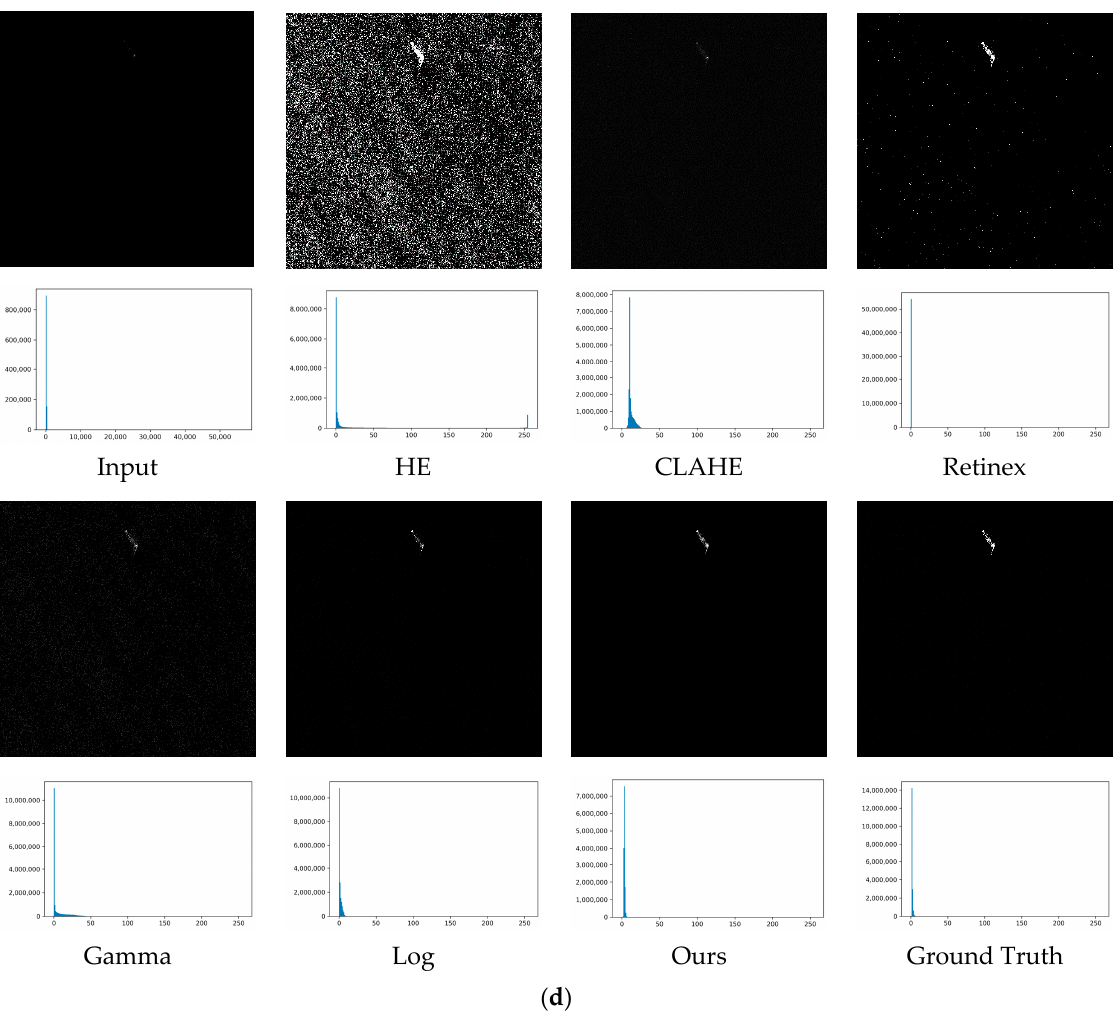
Figure 7. Visual results on synthesized images. The histogram exhibits the pixel distribution in the image. ( a – d ) Comparison of different single images.